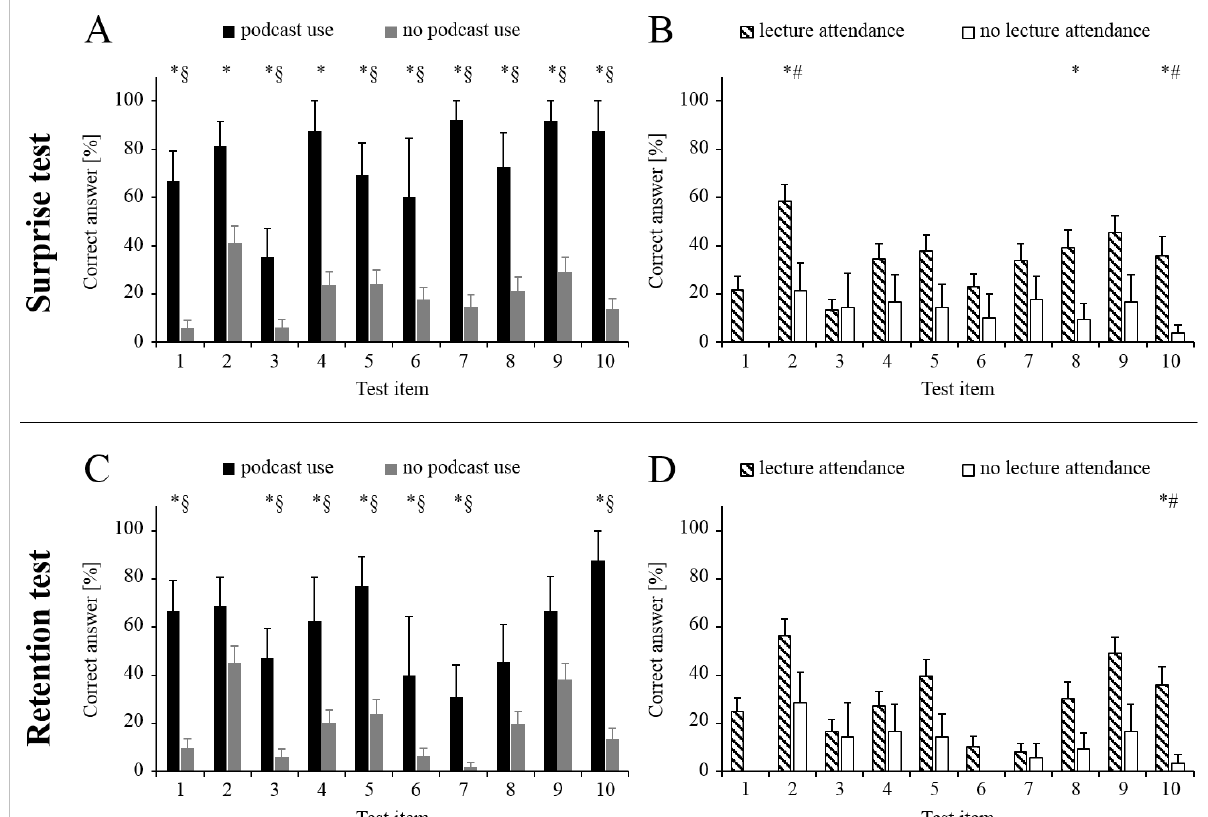
Figure 2. Student performance in the surprise and retention tests (columns represent the percentage of students providing a correct answer; error bars represent standard errors). * P<.05 for direct comparison (chi-square test); § P<.05 in a logistic regression adjusted for age, gender, exam performance, and lecture attendance; # P<.05 in a logistic regression adjusted for age, gender, exam performance, and podcast